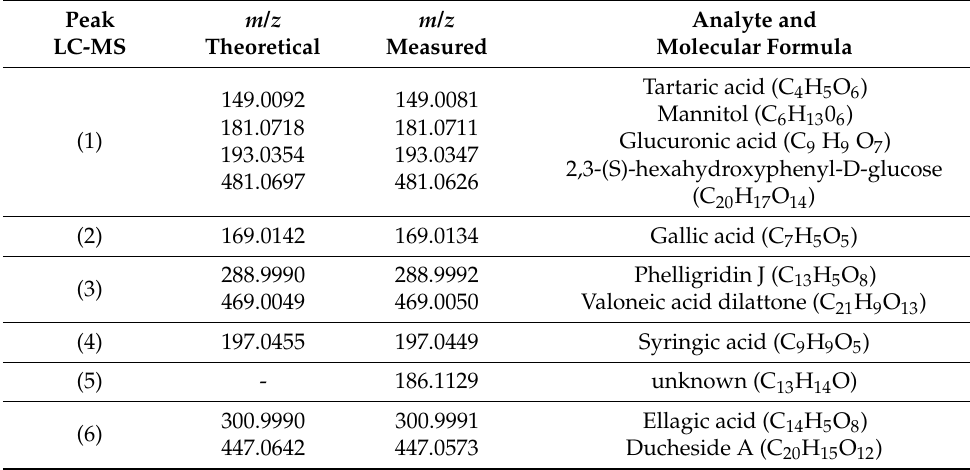
Table 5. Chemical characterization results (adapted from Castagna et al.,